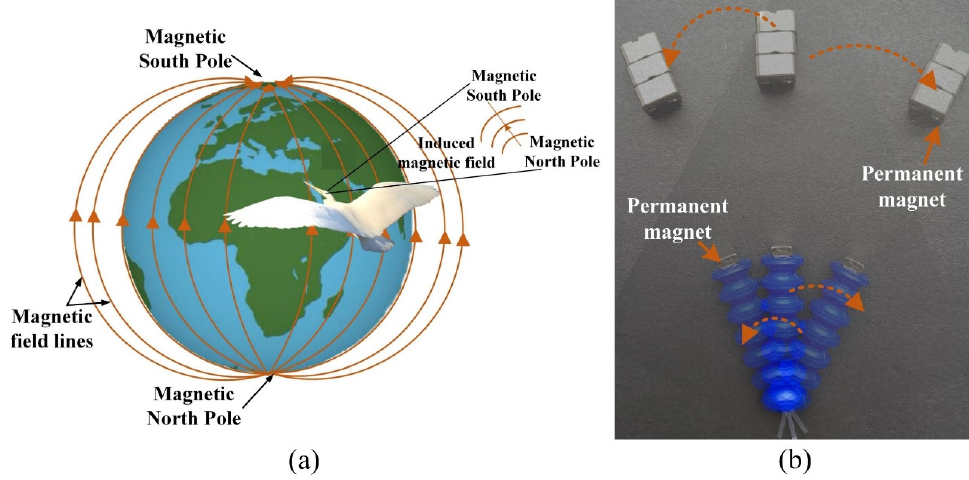
Figure 1. The schematic of the magnetic field navigation ( a ) the schematic diagram of navigation of migratory birds; ( b ) the schematic diagram of navigation of the robot.